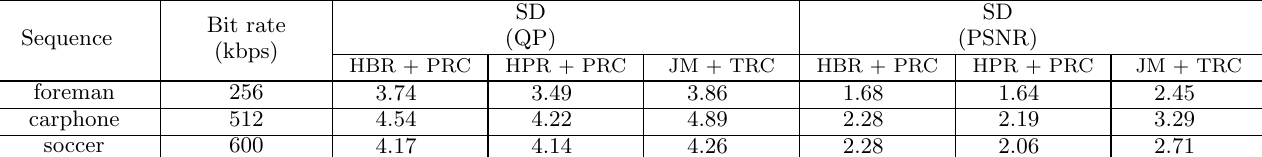
Table 1: Standard Deviation of QP and PSNR variations for CIF Test Sequences